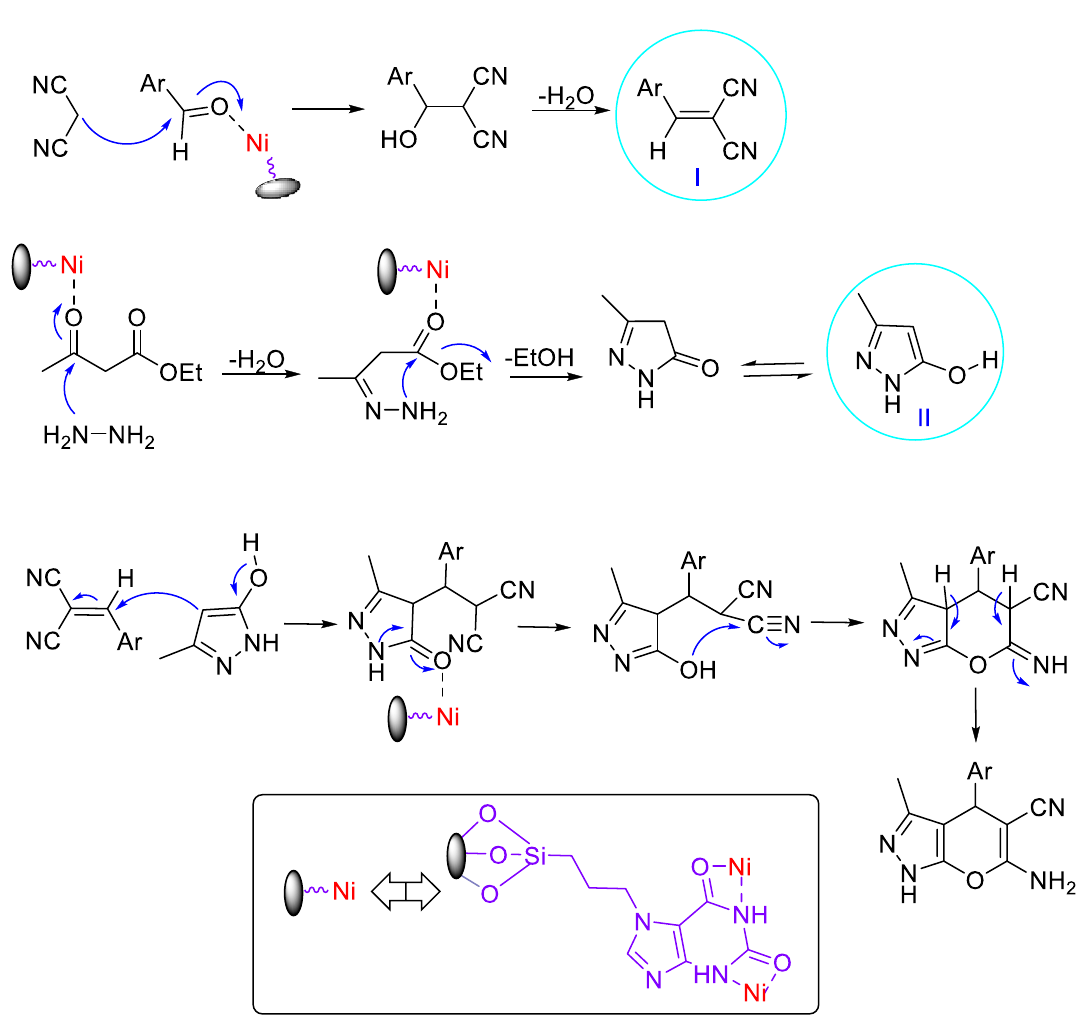
Figure 22. The possible mechanism for the synthesis of